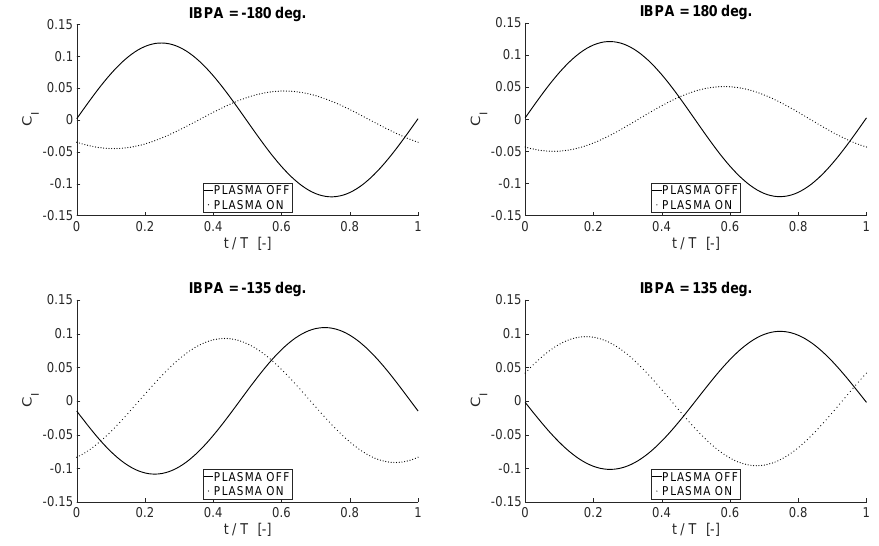
Figure 17. Time history of the lift coefficient C l on the central blade for the last simulated period; ) Hz, T = 1/f; IBPA = [ ± 180, ± 135 ] Re ∼ 195,000; α = 2 + sin ( 2 π f t + 4 × IBPA π 180